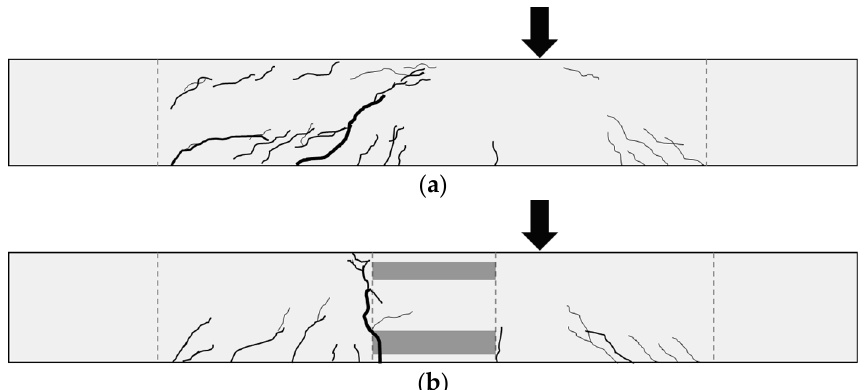
Figure 10. Crack propagation of shear test specimens: ( a ) MCS; ( b ) PCS.